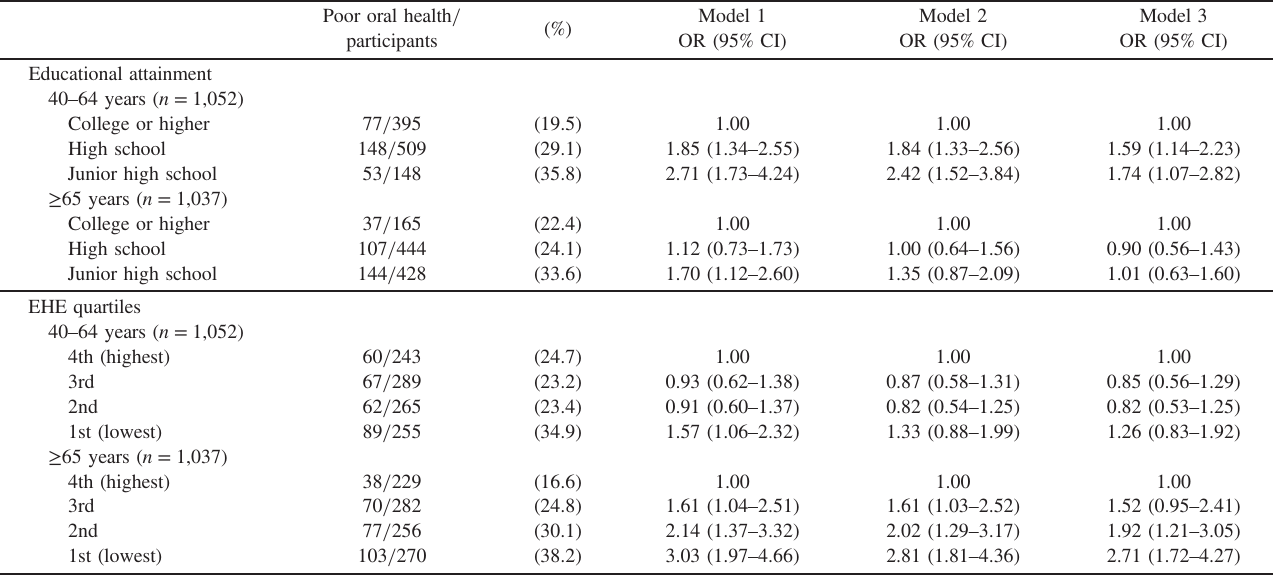
Table 3. Associations of educational attainment and EHE with poor oral health according to age categories: NIPPON